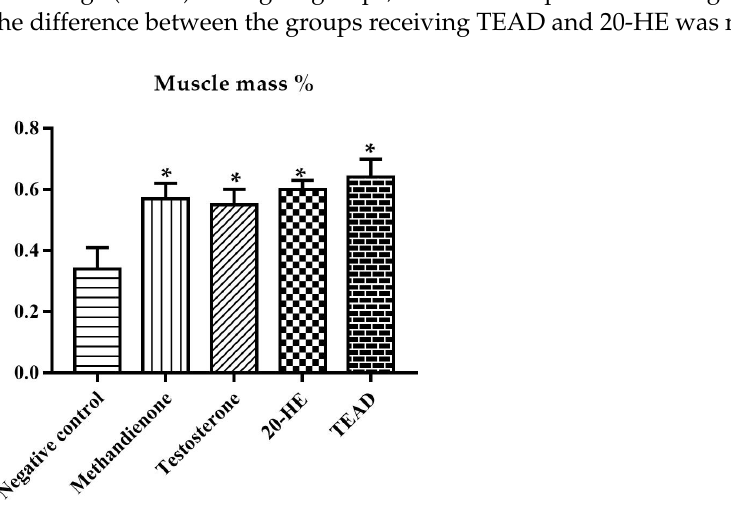
Figure 12. Muscle mass % of treated rats. * : Significantly different from the negative control group at p < 0.0001.